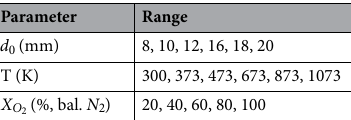
Table 2. Range of experimental conditions.